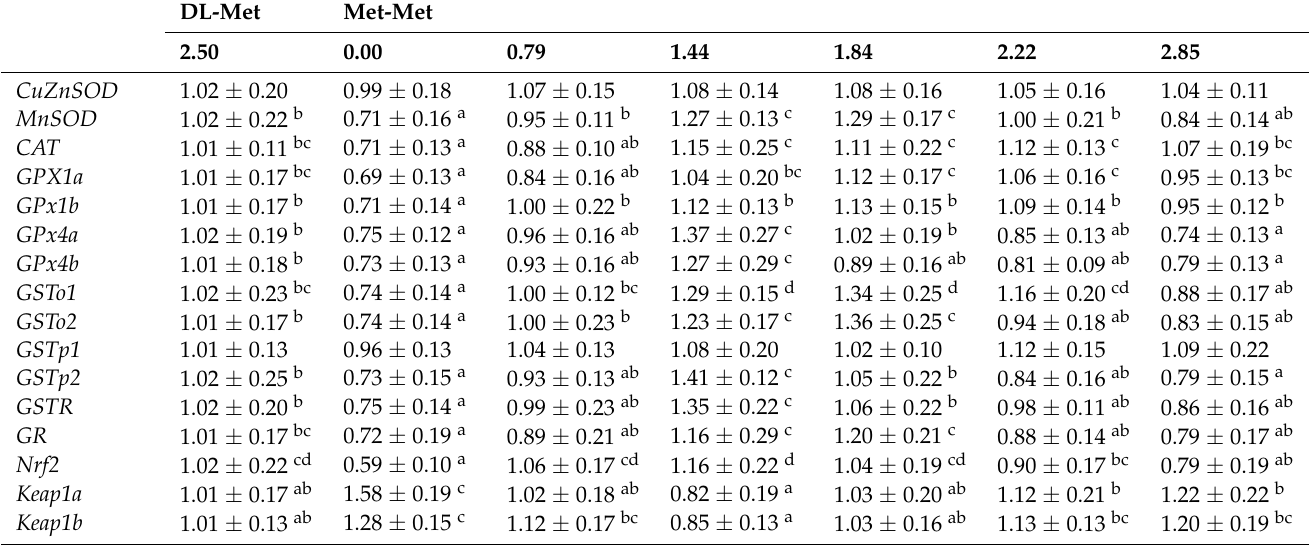
Table 4. Effects of dietary DL-Met and Met-Met supplementation (g/kg diet) on relative gene expressions of antioxidant enzymes and Nrf2 signaling in the proximal intestine of juvenile grass carp.